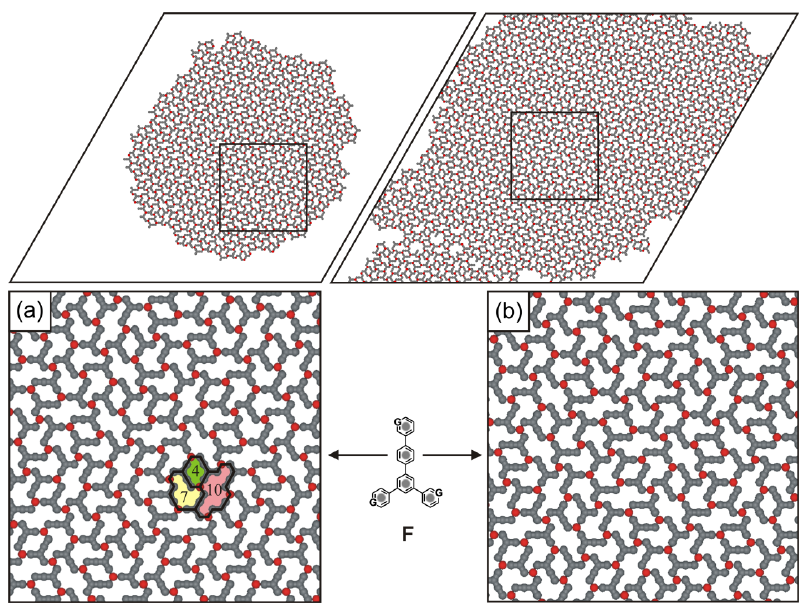
Figure 5. ( a ) Exemplary aperiodic metal–organic network composed of 600 metal atoms and 600 ligands F in a 1:1 stoichiometric ratio at surface coverage θ ∼ 0.21, T = 0.001; ( b ) adsorbed overlayer comprising 1200 metal atoms and 1200 ligands F in a 1:1 stoichiometric ratio at surface coverage θ ∼ 0.42, T = 0.001. The solid black lines in the bottom-left inset mark the edges of empty nanopores differing in size and shape. Inside the nanopores marked in different colors (pink, chalk, and light-green) the numbers of empty adsorption sites are given.